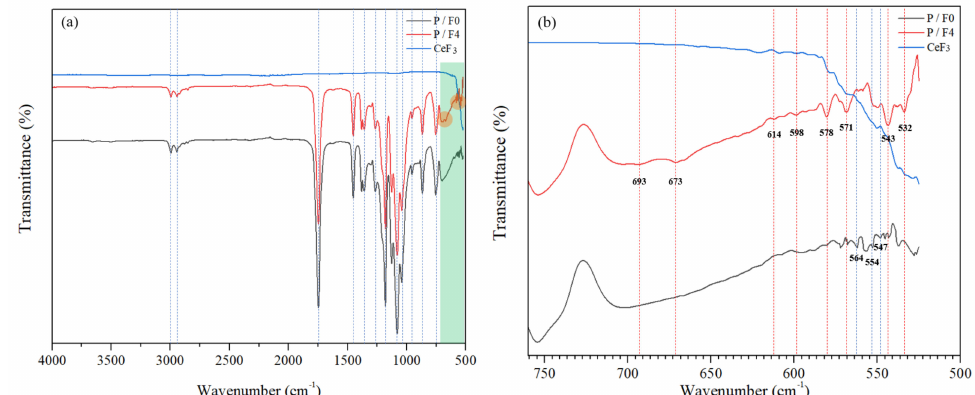
Figure 3. Infrared spectra of CeF 3 , P/F0 and P/F4 films. ( a ) Wavenumber range 500–4000 cm − 1 ; ( b ) Wavenumber range 500–730 cm − 1 .